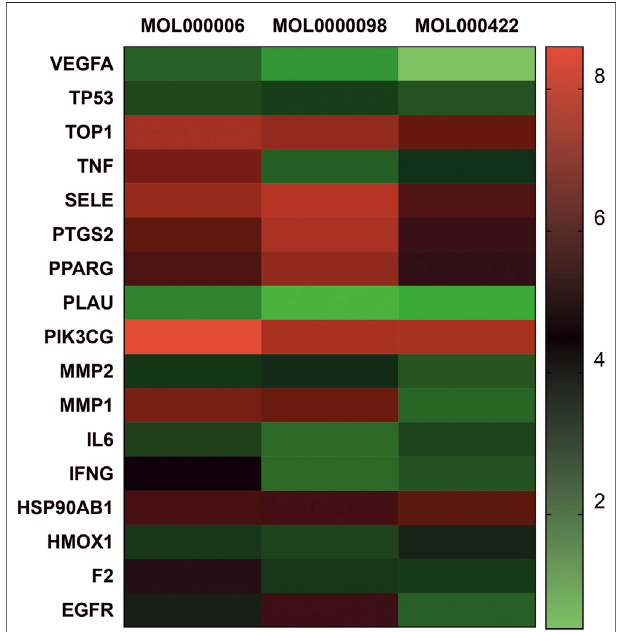
FIGURE 7 | Heat map of Molecular docking. Molecular models of the binding of quercetin (MOL0000098), kaempferol (MOL000422), luteolin (MOL000006) with TOP, MMP2, MMP9, IFNG, SELE, PLAU, VEGFA, HMOX1, F2, TNF, TP53, PPARG, PIK3CG, IL6, PTGS2, HSP90AB1, and EGFR,